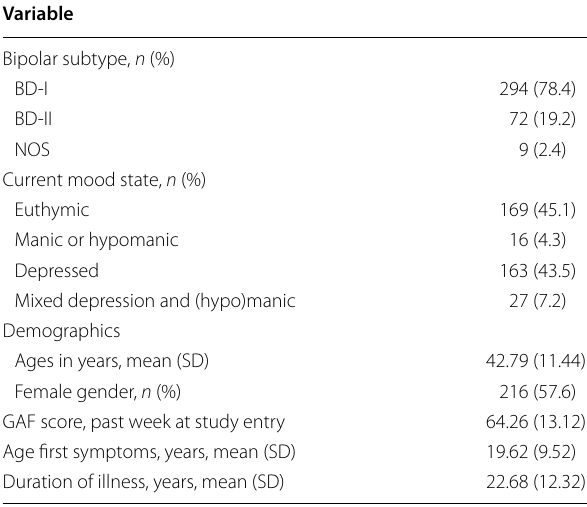
Table 1 Demographic and clinical